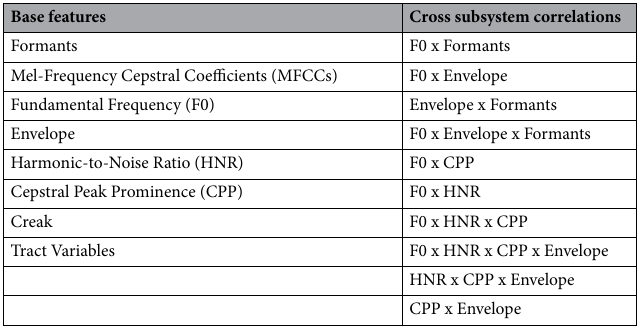
Table 2. Acoustic features used to build coordination features. List of features and combination of features that were used to assess coordination differences within and across speech production subsystems. Deltas of each of the entries below were also used to assess the correlations and coordination across feature